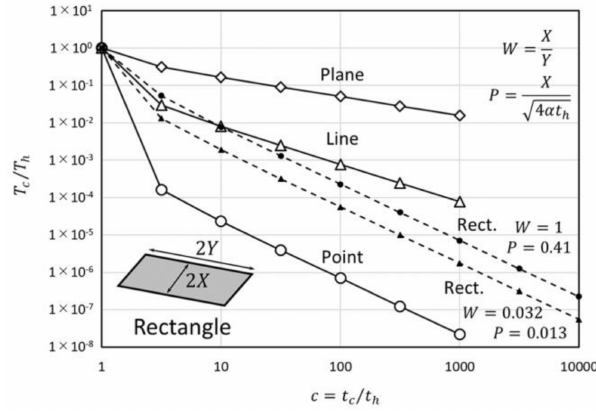
Figure 7. Temperature-decreasing ratio of the rectangle heat